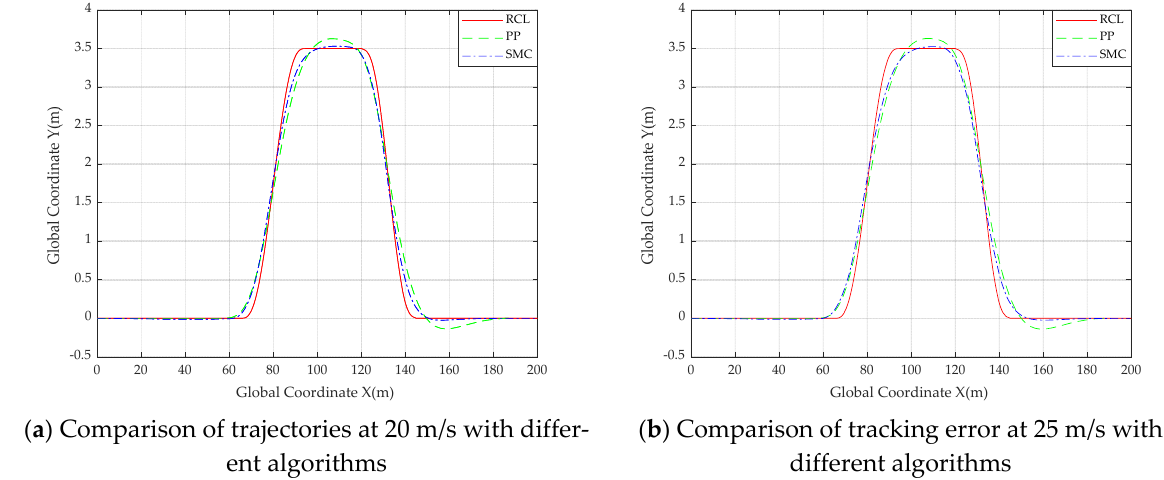
( b ) Comparison of tracking error at 25 m/s with different algorithms Figure 24. Comparison experiments between PP and SMC algorithms at different speeds. Figure 24. Comparison experiments between PP and SMC algorithms at different